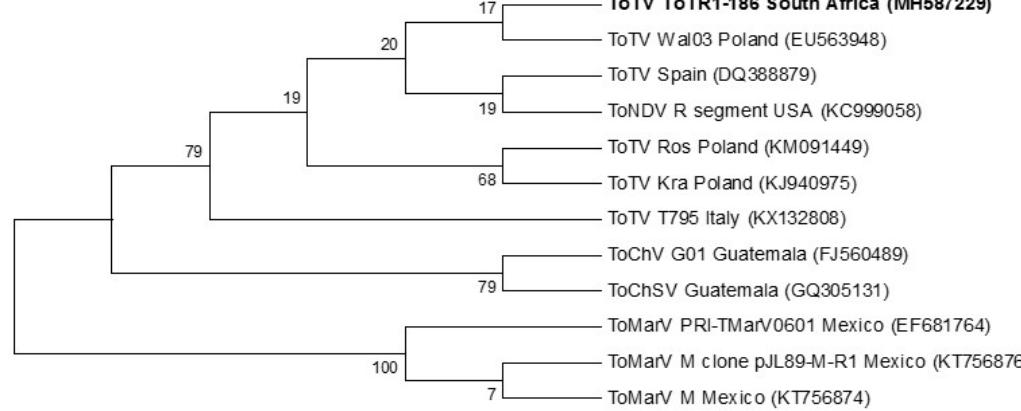
Figure 5. Phylogenetic relationship of the ToTV RNA-1 polyprotein from South Africa (ToTR1-186) in conjunction with all other tomato-infecting torradovirus isolates to date. Evolutionary analysis was inferred using the Maximum likelihood method and 1000 bootstrap replicates based on the General Time Reversible model [23]. Accession numbers are in parenthesis.